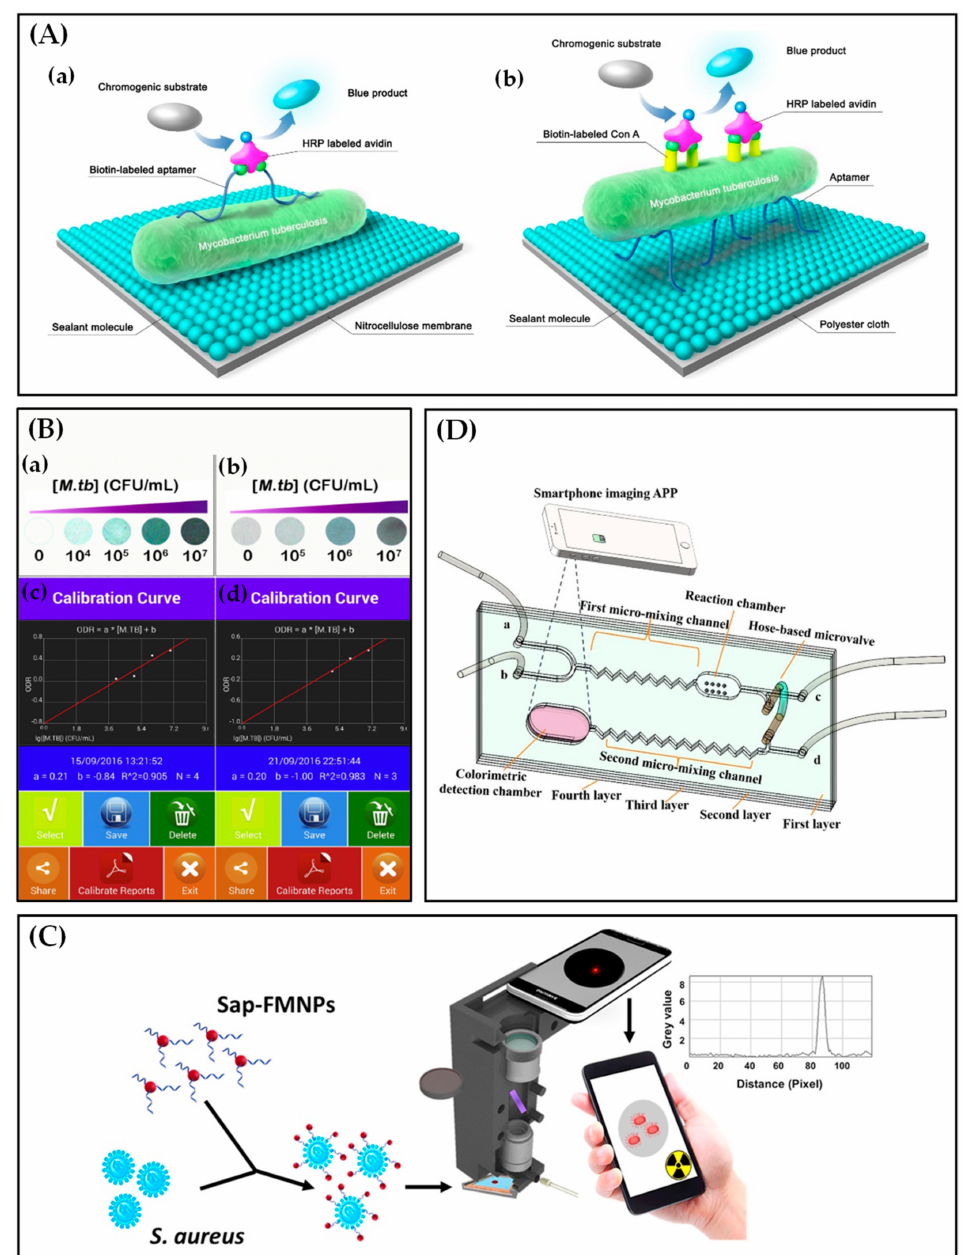
Figure 5. ( A ) Schematic illustrations of direct ( a ) and indirect ( b ) dot-blot assay. Reprinted with permission from Ref. [102], copyright 2018, Elsevier. ( B ) The color spots with varying M.tb con- centration and application interfaces of the calibration curves in the direct ( a , c ) and indirect ( b , d ) dot-blot system, respectively. Reprinted with permission from Ref. [102], copyright 2018, Elsevier. ( C ) Schematic illustration of Staphylococcus aureus capture and quantitative detection in minimally processed samples. Reprinted with permission from Ref. [103], copyright 2018, Elsevier. ( D ) The schematic representation of the proposed microfluidic colorimetric biosensor based on a smartphone imaging APP for detecting Salmonella typhimurium. Reprinted with permission from Ref. [104], copyright 2021,